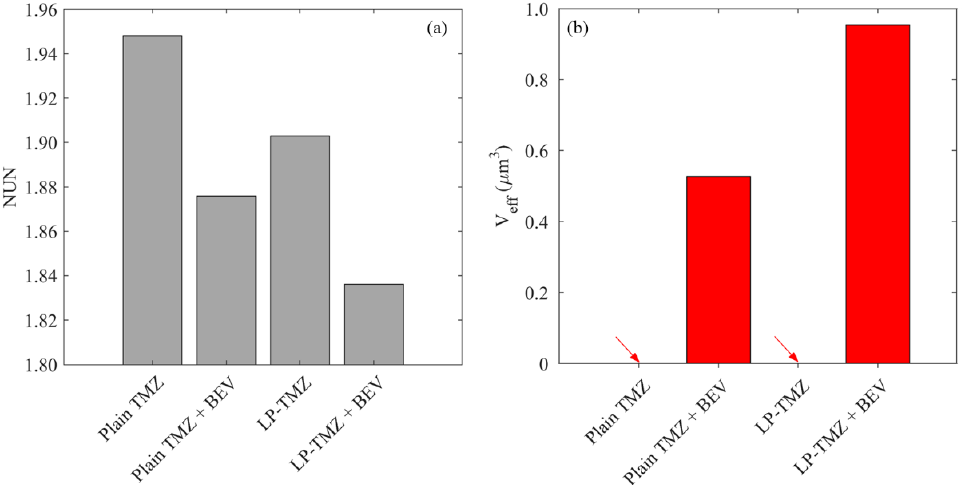
Figure 13. Comparisons of ( a ) drug distribution non-uniformity, and ( b ) effective distribution volume between different regimens in the brain tumor on Day 3.